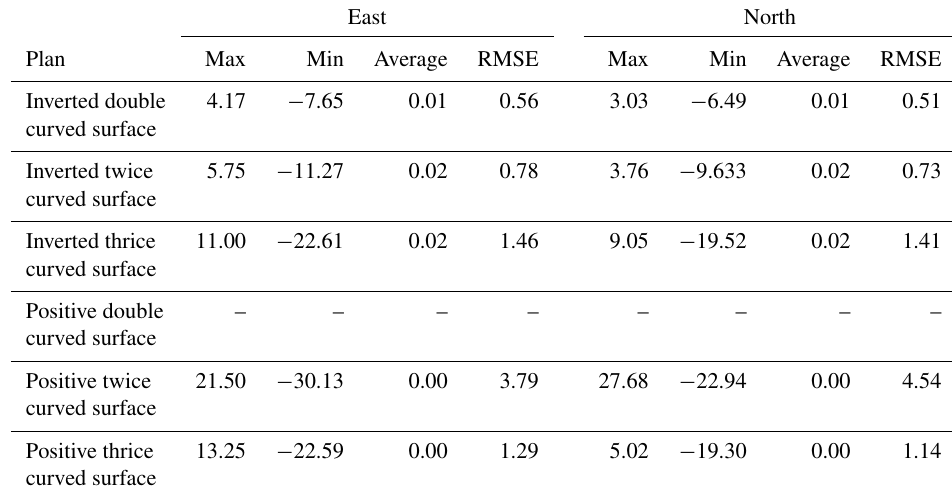
Table 1. Velocity residuals statistics for different kernel functions (mmyr − 1 ).